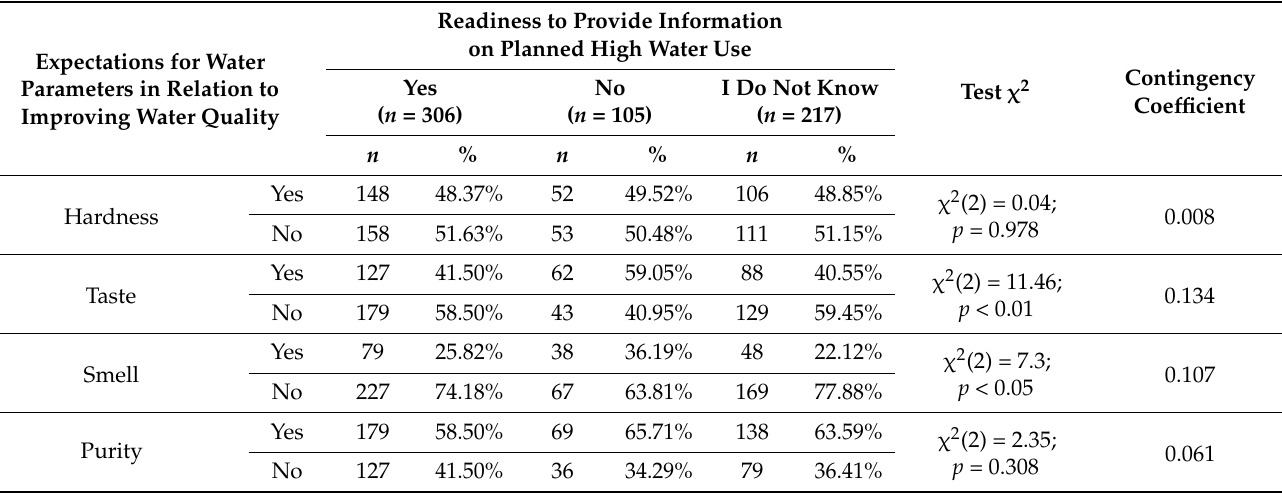
Table 4. Relationship between respondents’ willingness to provide information about planned high water use and their expectations about water parameters in relation to water quality